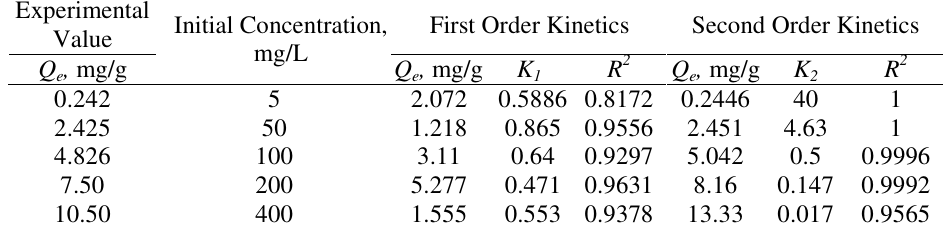
Table 3. Kinetic parameters for the effect of initial adsorbate concentration